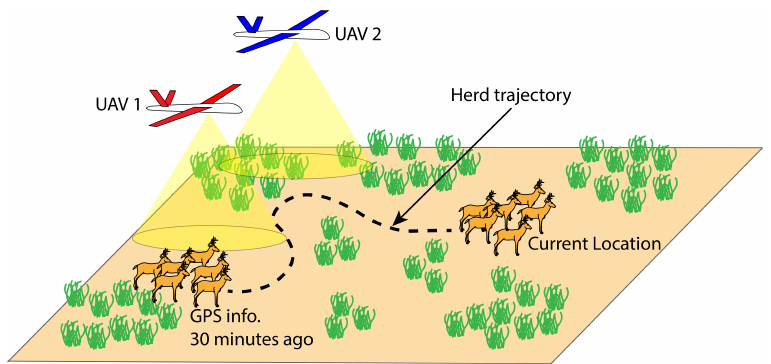
Figure 1. Illustration of wildlife monitoring using a team of